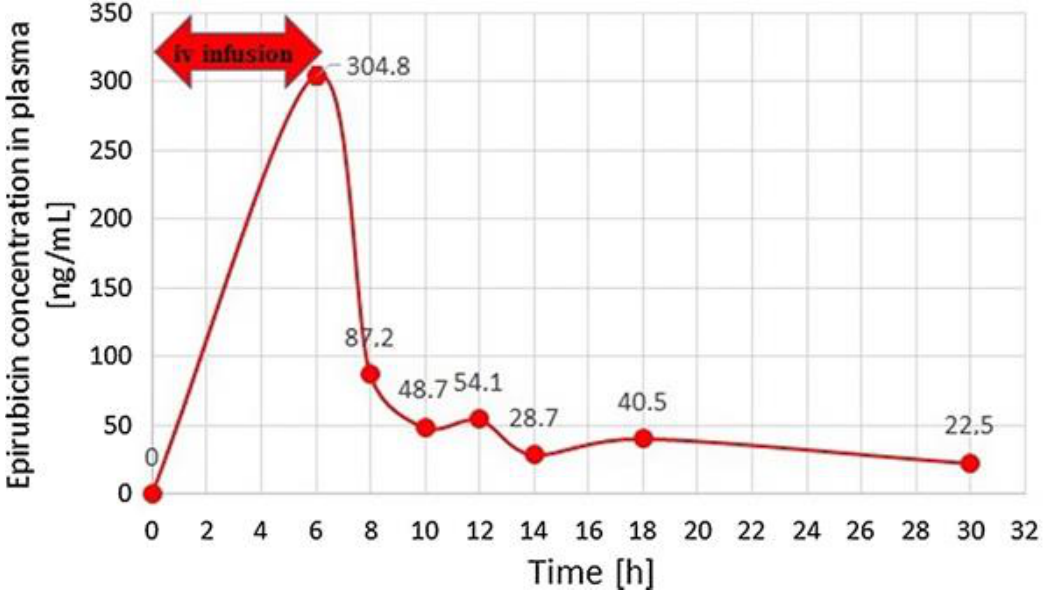
Figure 3. The profiles of epirubicin concentrations in plasma samples from a 19-year-old patient with metastatic alveolar rhabdomyosarcoma after a 6-hour intravenous infusion of epirubicin (150 mg/m 2 ) [37].